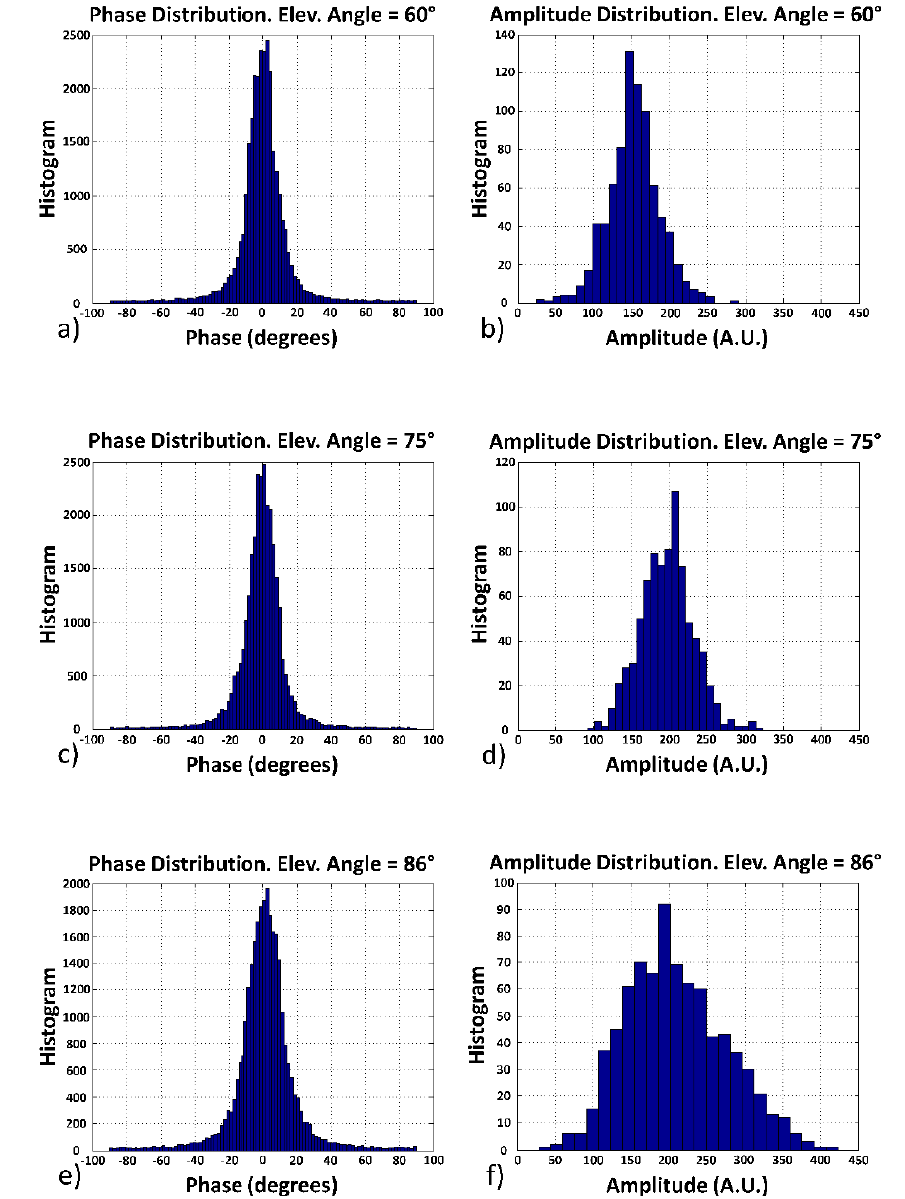
Figure 12. At an elevation angle of ( a , b ) θ = 60°, ( c , d ) θ = 75° and ( e , f ) θ = 86°, (a,c,e) e e e histogram of the phase and (b,d,f) amplitude of the signals after retracking for a SWH = 36 cm. The length of the dataset is 30 min, sampled at 10 Hz, showing that the random complex vectors add up together, privileging a certain direction in the complex plane (Figure 12a,c,e). As can be appreciated, the phase’s standard deviation of the retracked signals is actually quite small, which shows a strong coherent component being tracked. As the elevation angle increases from θ = 60° − 86°, the phase e standard deviation increases also from 13.4° to 19.1° (Figure 12a,c,e and Table 2), and the kurtosis decreases from 17.5 to 8.5 (Table 2). This is a clear indication that the amount of incoherent scattering increases (the pdf becomes more like a Gaussian one), due to the larger contribution of the wave crests and valleys at larger elevation angles. This is also in agreement with the evolution of the amplitude distribution, which tends to a Rayleigh distribution, as the elevation angle increases (Figure 12b,d,f and Table